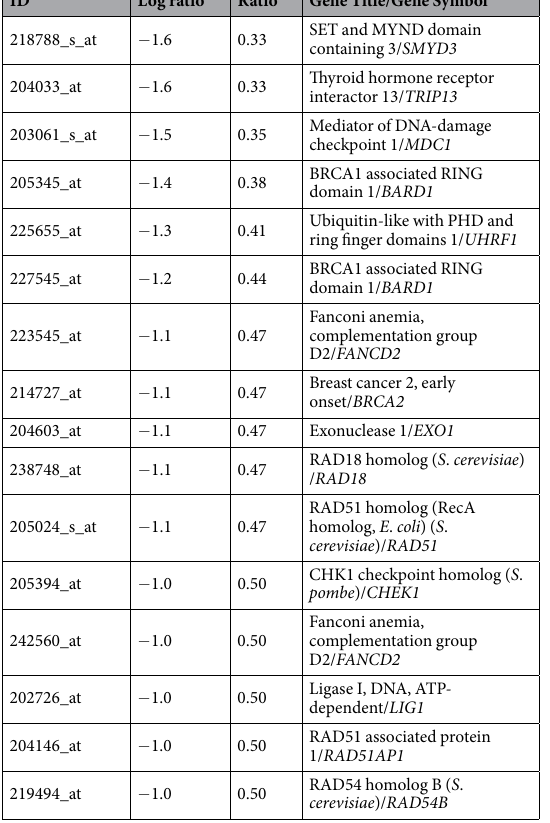
Table 1. Down-regulated HR genes in shSMYD3/shLuc array data (genes with < 0.5 fold